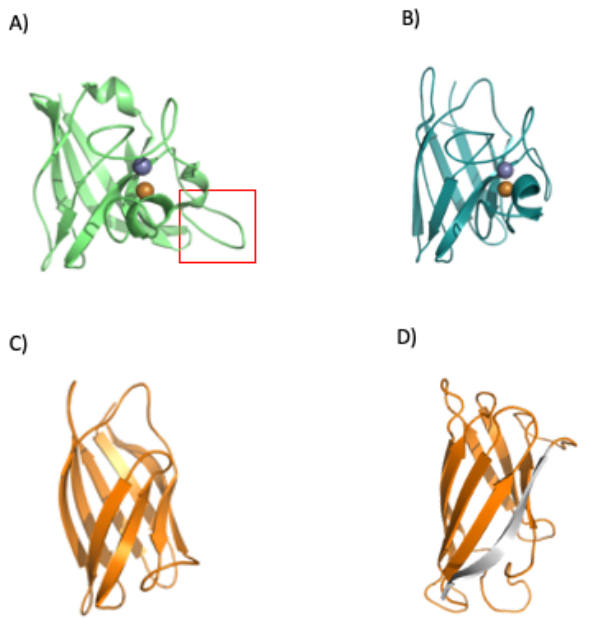
Figure 10. Folding and regulation of SOD1. The bacterial SOD displays a loop insertion in the metal binding area ( A ) red rectangle, which makes the protein more prone to misfolding when there is no binding of its cognate metals. The human protein does not show the loop ( B ) (PDBid 1spd), and a loopless version of the human protein (without the metal binding area, panel ( C ) was analyzed in our previous work ( C ) [98]. The analysis showed a probable folding intermediate that lacks the terminal beta (shown in gray, panel ( D )).